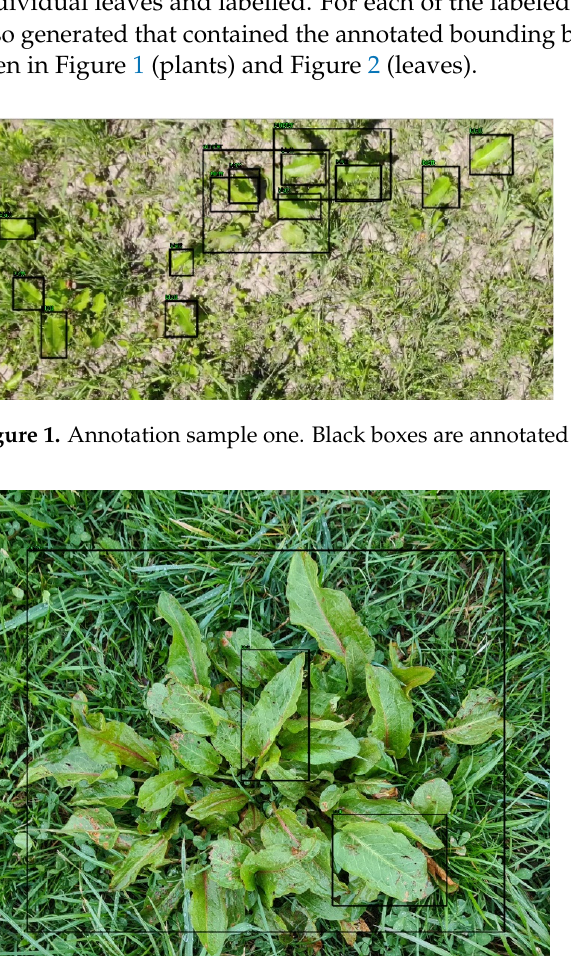
Figure 2. Annotation sample two. Black boxes are annotated R. obtusifolius